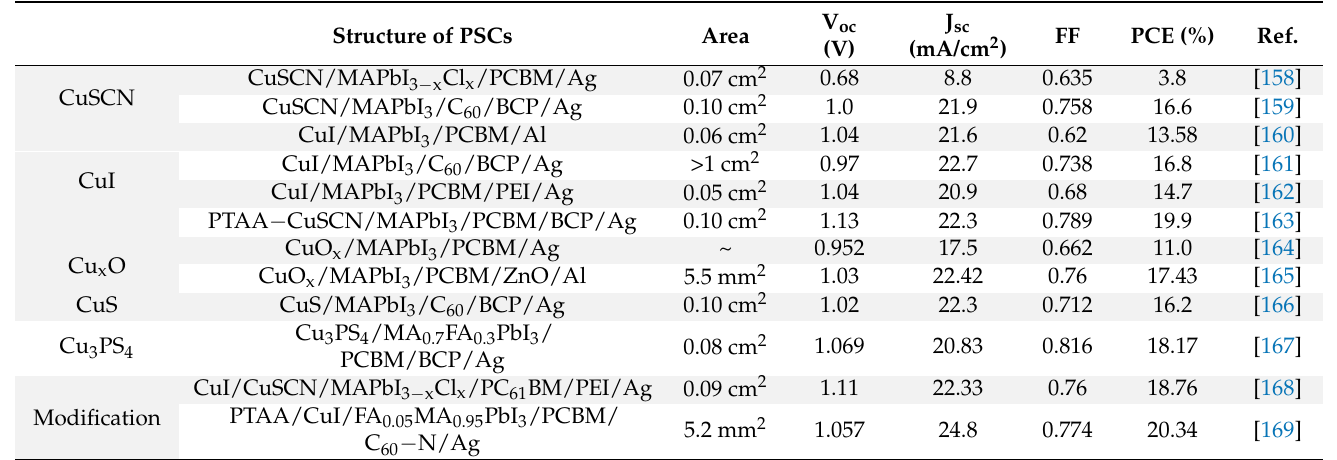
Table 15. Performances of several representative inverted PSCs on the basis of the Cu − based HTL structures.